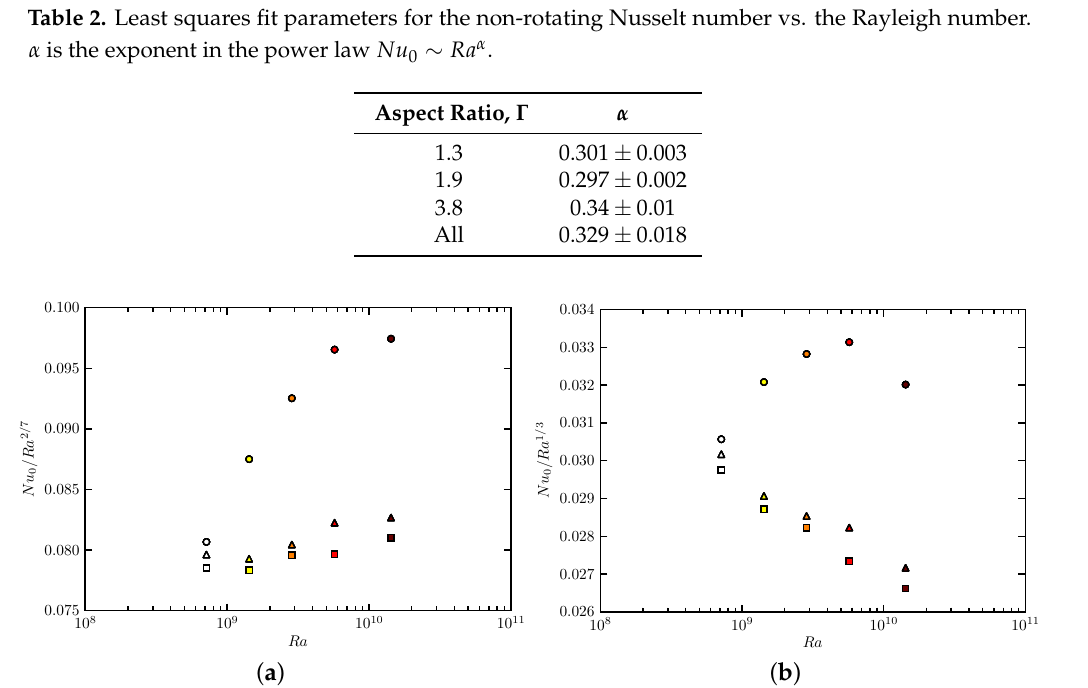
Figure 4. The dependence of the Nusselt number for the non-rotating system, Nu 0 , on the Rayleigh number, Ra with ( a ) compensation by a Ra 2/7 scaling law, ( b ) compensation by a Ra 1/3 scaling law. Darker colours represent higher applied temperature differences, for ∆ T = 0.5 °C, for ∆ T = 1 °C, ◦ • for ∆ T = 2 °C, for ∆ T = 4 ° C and for ∆ T = 10 °C. Shapes represent different aspect ratios, circles • • • for Γ = 3.8 whilst Γ = 1.9 and Γ = 1.3 are represented by squares and triangles